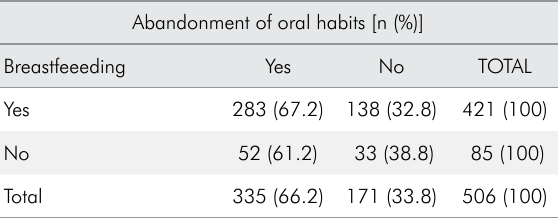
Table 4. Distribution of the adoption of breastfeeding in relation to the abandonment of oral habits.